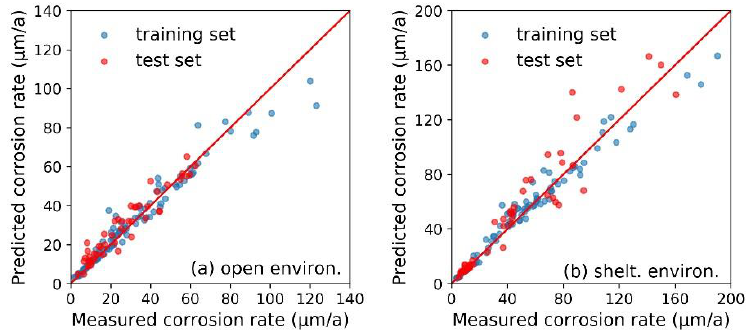
Figure 2. The random forest algorithm-based corrosion rate prediction models for steel samples under ( a ) open environment and ( b ) sheltered environment at the exposure test sites of Tsukuba, Choshi and Miyakojima. Table 3. The predictive accuracy of random forest models for steel samples under open and sheltered environments at the exposure test sites of Tsukuba, Choshi, and